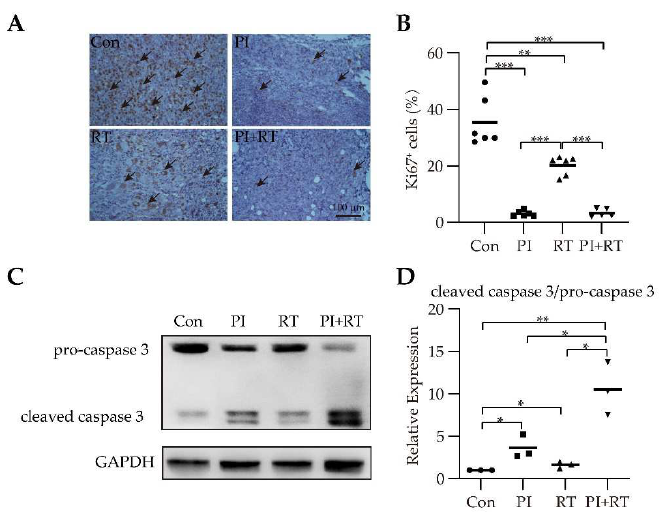
Figure 4. The effect of PI in combination with RT on cell proliferation and apoptosis in subcutaneous LLC lung cancer model. ( A ) Immunohistochemical staining: Arrows showed Ki67-expressing cells. ( B ) Assay quantification for Ki67 at 400× magnification ( n = 6). ( C ) Western blotting assay results of pro-caspase 3 and cleaved caspase 3. ( D ) Assay quantification for caspase 3: Ratio of cleaved caspase 3/pro-caspase 3 ( n = 3). GAPDH was used as a loading control for western blotting. The statistical differences between groups were analyzed with an unpaired two-tailed Student’s t-test. The data showed the mean ± SEM. Statistical differences were indicated by the p values, *, p ≤ 0.05; **, p ≤ 0.01; ***, p ≤ 0.001.